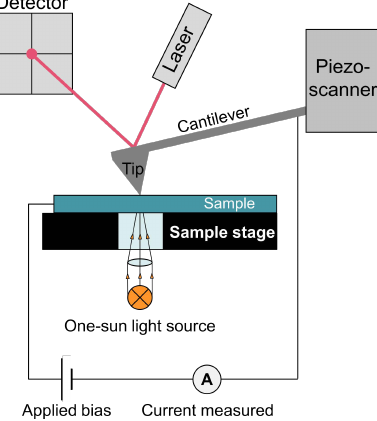
Figure 6. Simple schematic of the PC-AFM